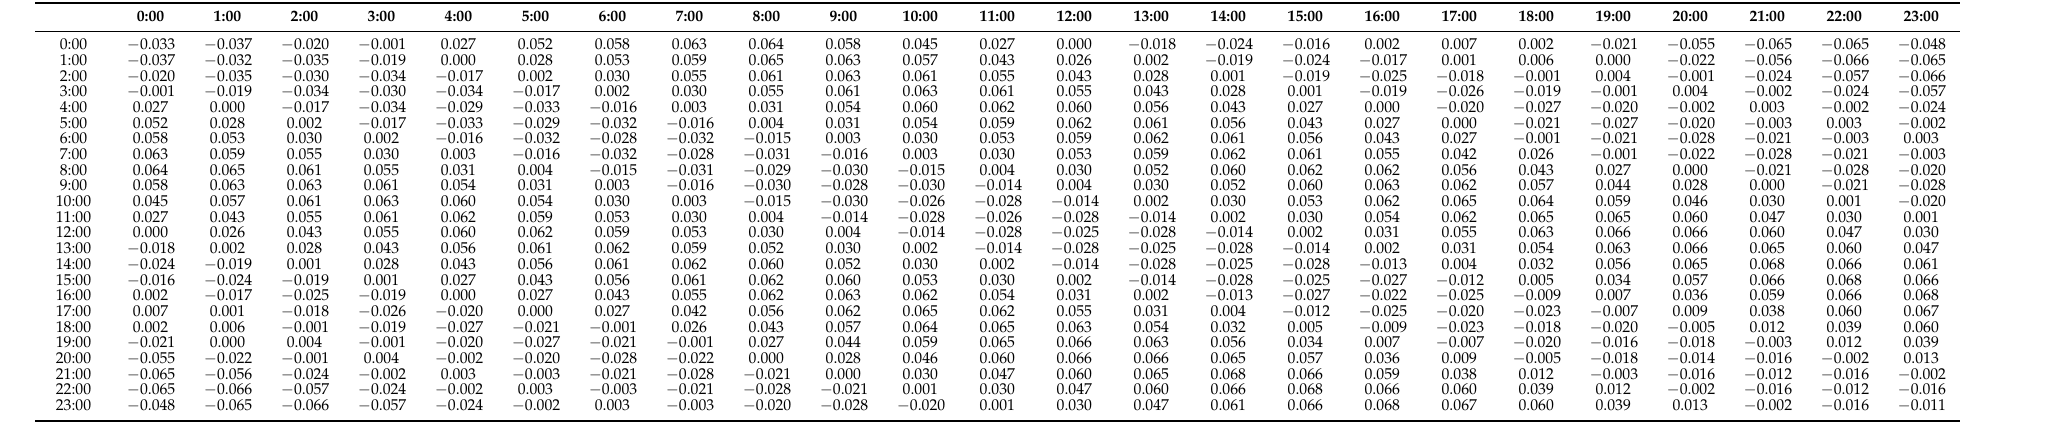
Table A4. Price elasticity coefficient of electricity demand in